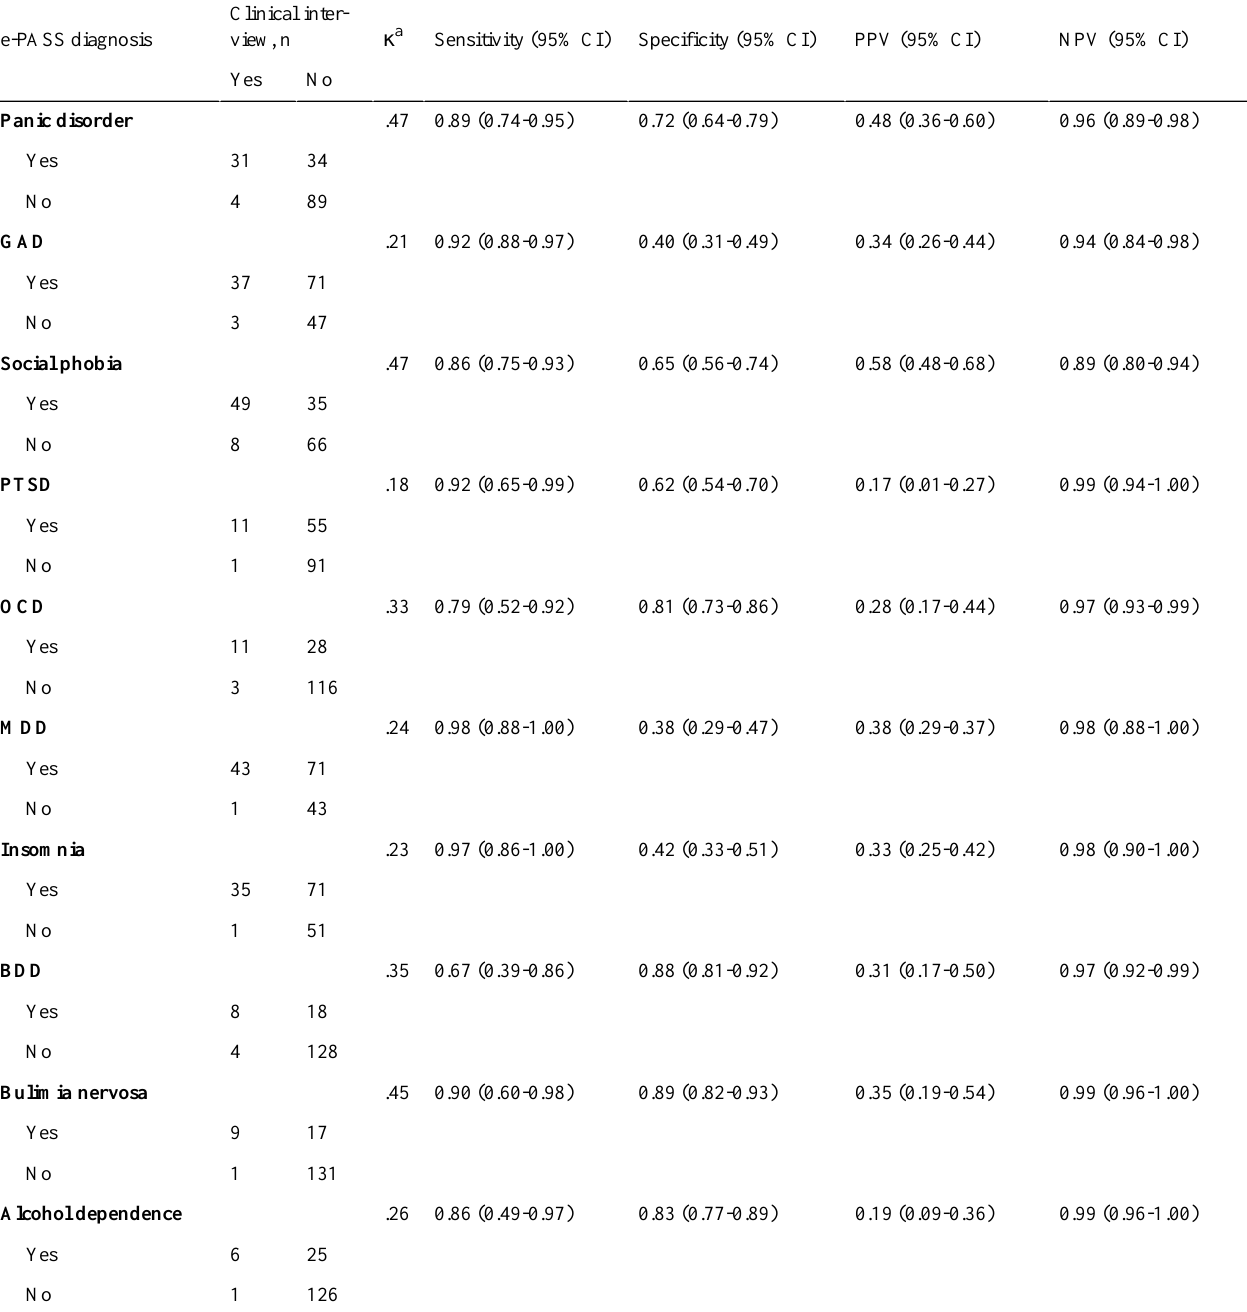
Table 3. Classification statistics of the e-PASS subclinical or clinical diagnoses against clinical interview clinical diagnoses